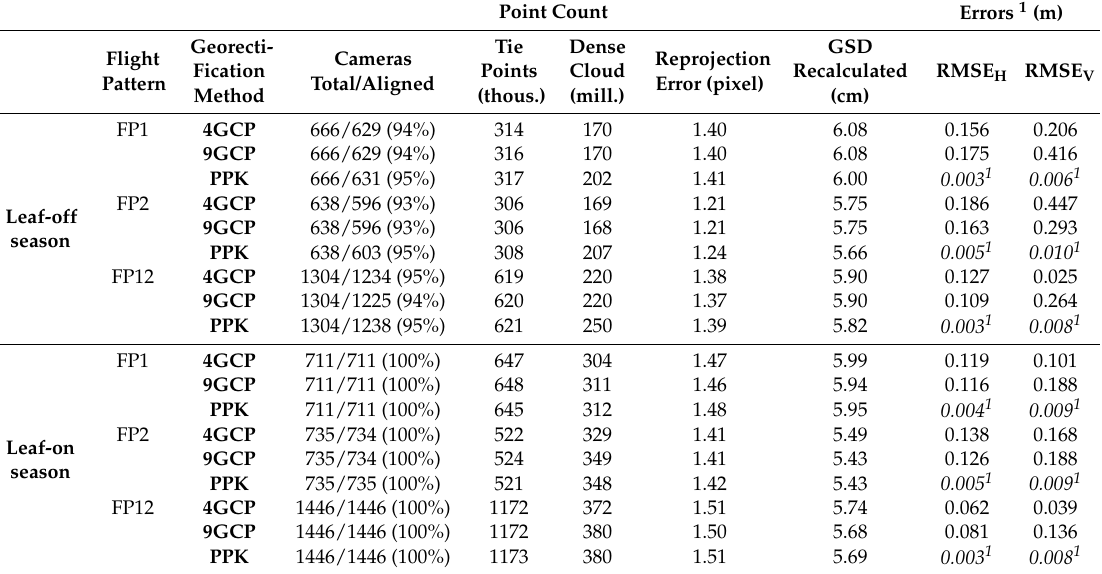
Table 2. Results of photogrammetric processing for different vegetation conditions, flight patterns and GCP configurations.